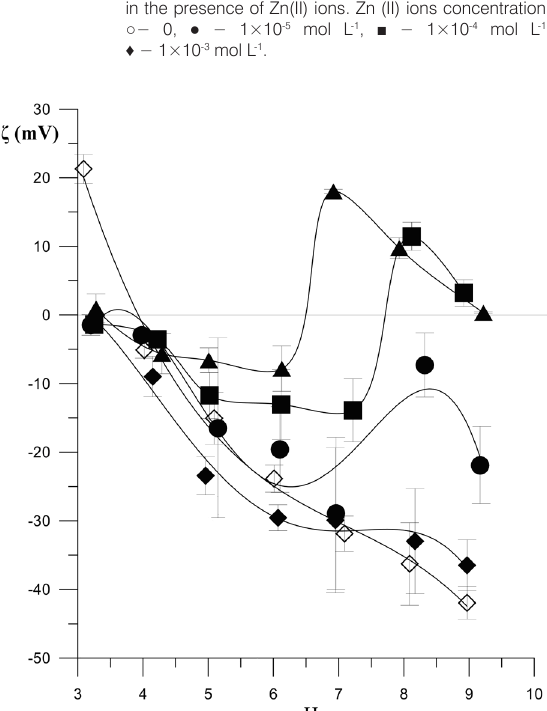
Figure 7. The potential ζ of TiO (amorphous) as a function of pH 2 in the presence of Zn(II) ions. Zn (II) ions concentration: